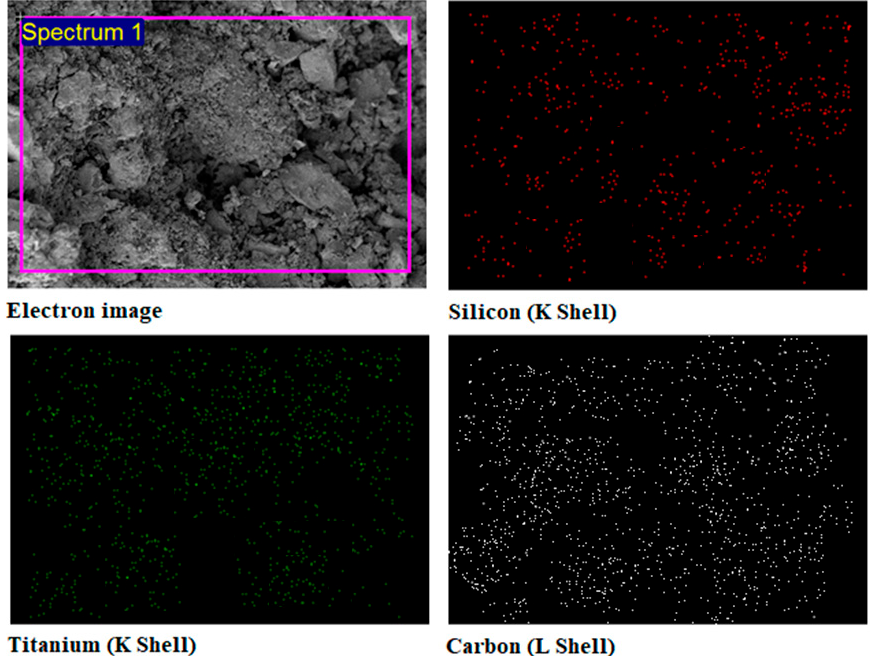
Figure 20. Elemental Mapping of Ti-6Al-4V-SiC(15 Wt.%) composite processed under aging temperature (1150 °C), aging time (four hours), heating rate (25 °C/min), and cooling rate (5 °C/min) from electron dispersive X-ray analysis.